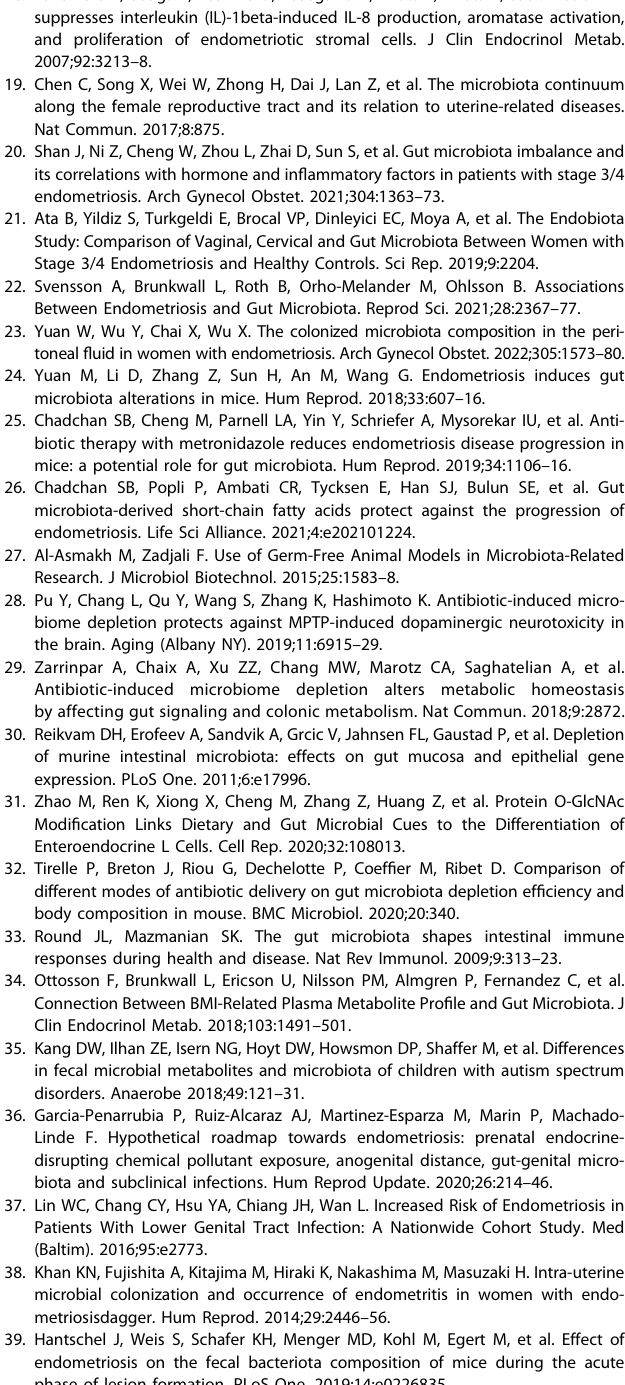
Fig. 7 Fecal metabolites differ between mice with and without endometriosis. A The heat map depicting the metabolites that were differentially present between mice with and without endometriosis with cutoff of FDR < 0.25. B Quinic acid is present at higher level in feces of mice with endometriosis. Stool samples from mice with and without endometriosis were subjected to LC-MS (in the Baylor College of Medicine Metabolomics Core) to detect ~150 water-soluble metabolites. Each row is a metabolite, and each column is a stool sample from an individual mouse; ( n = 5 mice per group). Data are presented as mean ± SE. C MTT cell viability assays of iHEECs/Luc treated with 20 mM and 40 mM Quinic acid for indicated time points. Results are shown as mean ± SE ( n = 3) and experiment repeated three times. Ectopic endometriotic lesion D representative images, E number of lesions per mouse, F volumes and G masses from the vehicle and QA treated groups,14 days after induction of endometriosis. Data are presented as mean ± SE ( n = 5), * P < 0.05, ** P < 0.01, *** P < 0.001 and ns, non- signi fi